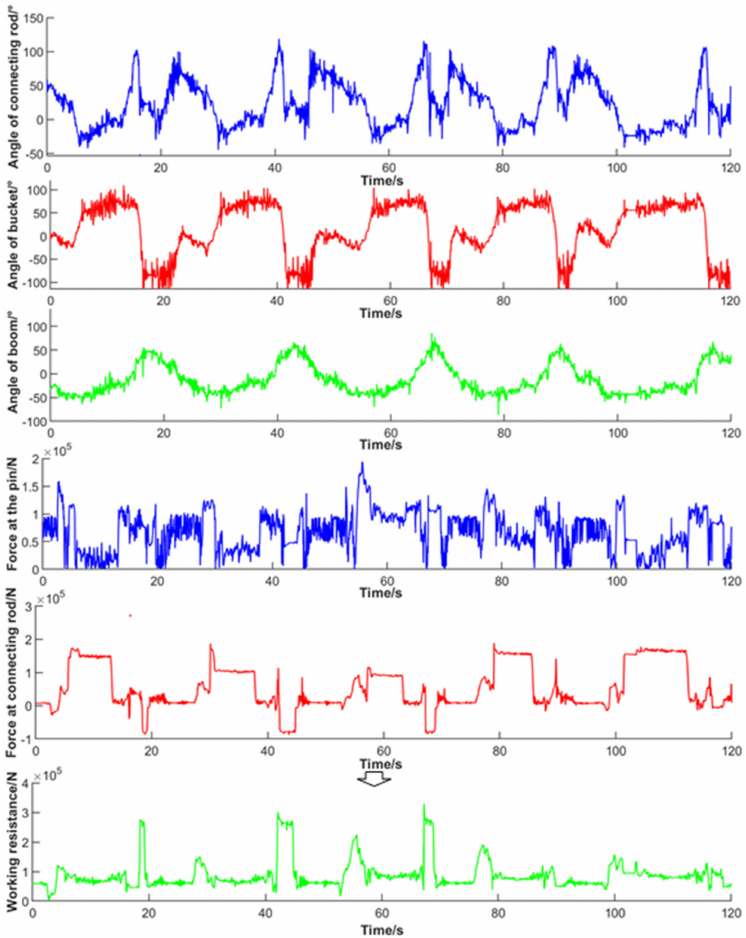
Figure 10. Working resistance indirect measurement parameter curve and synthetic resistance